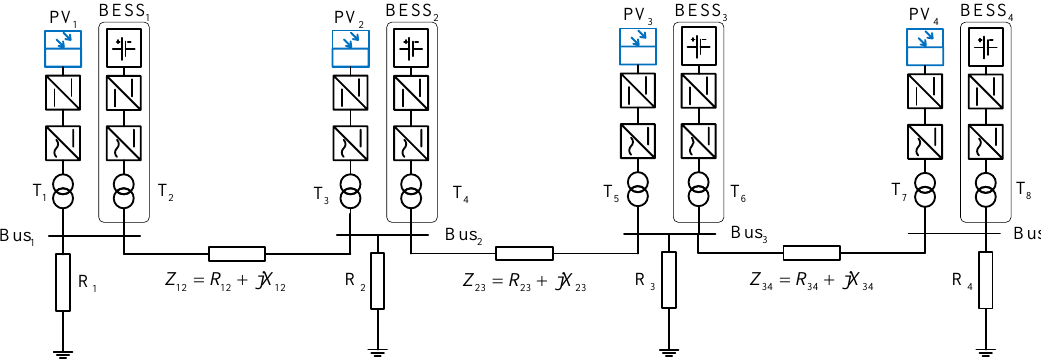
Figure 1. Isolated microgrid consisting of four BESSs, four PV sources, four local loads and three power